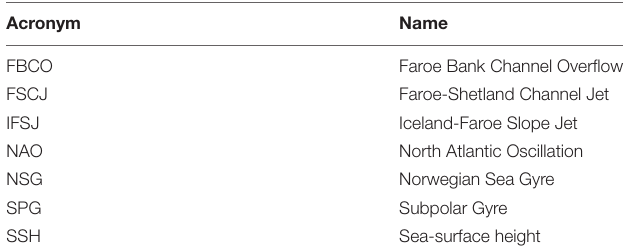
TABLE 1 | List of abbreviations, arranged in alphabetical